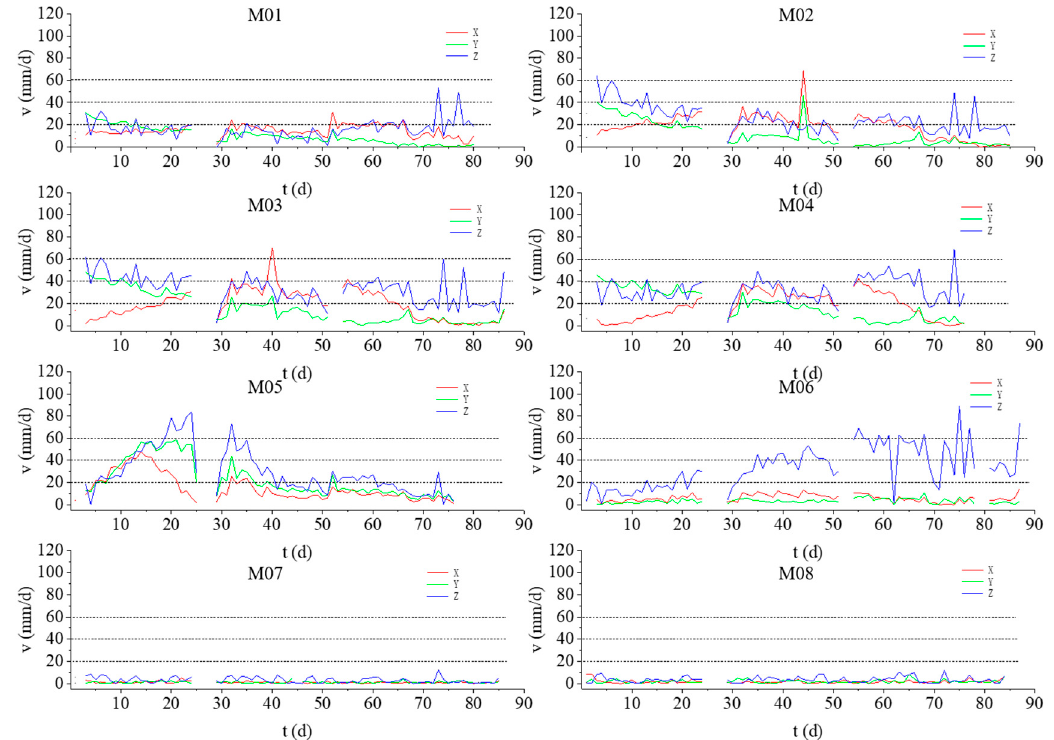
Figure 4. One-dimensional moving velocity curves.